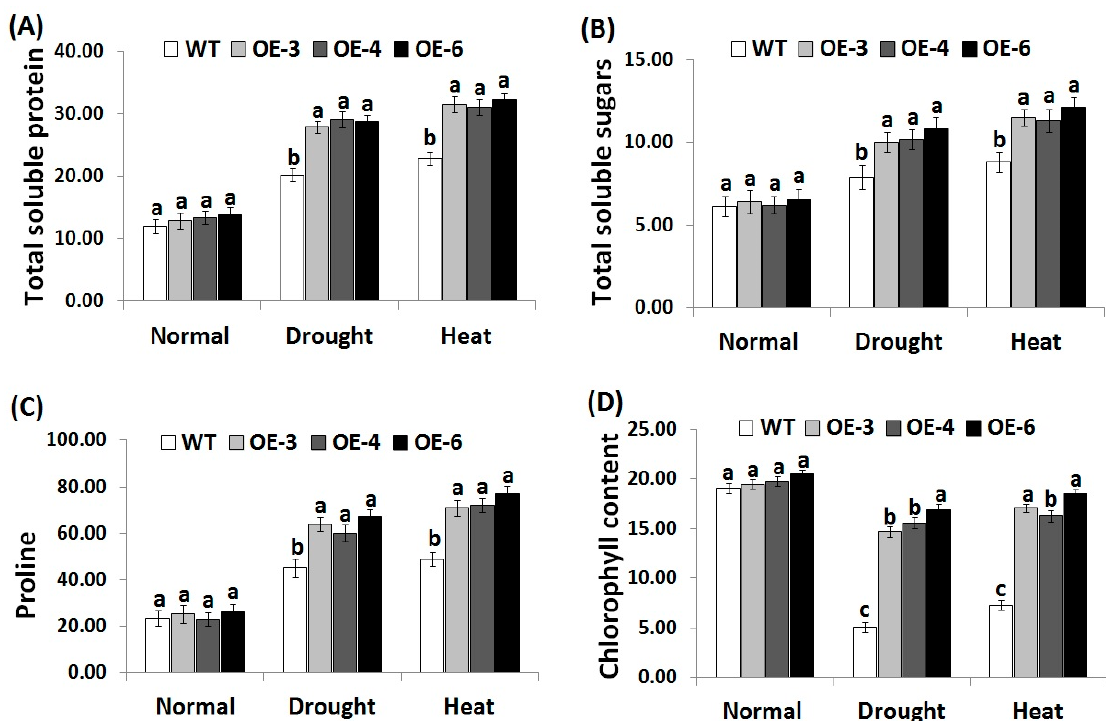
Figure 4. Contents of total soluble protein (mg g − 1 FW) ( A ), soluble sugars (mg g − 1 FW) ( B ), proline ( µ g g − 1 FW) ( C ) and chlorophyll (mg g − 1 FW) ( D ) of the wild-type and transgenic rice plants overexpressing OsRab7 subjected to normal, drought and heat stress conditions. Data are means ± SE ( n = 3). Different letters above the columns indicate significant differences between lines ( p ≤ 0.05).